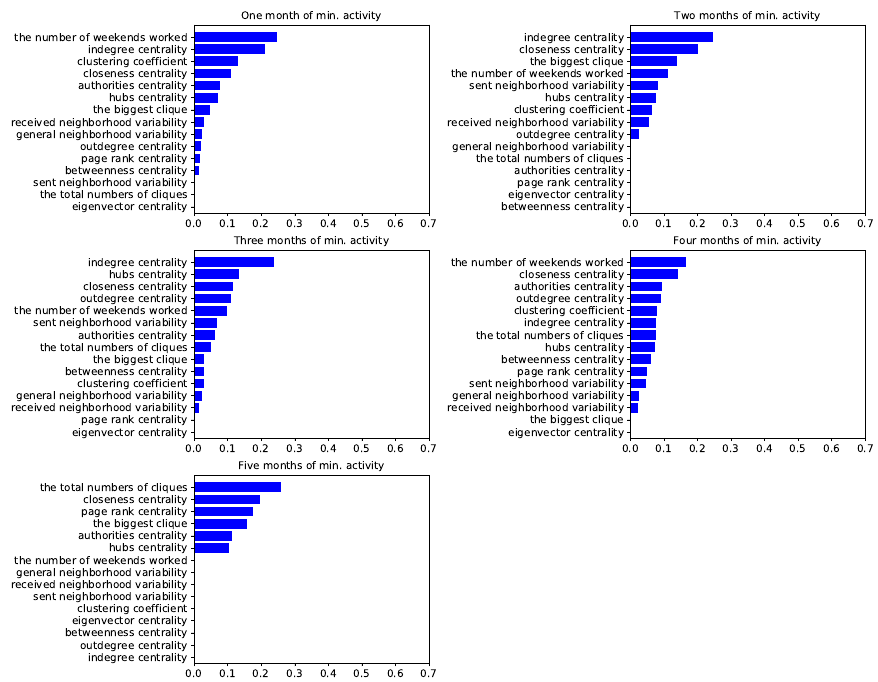
Figure A8. Features importance (Gini importance) for the Decision Tree which uses the full set of features for the Enron dataset with three levels of the